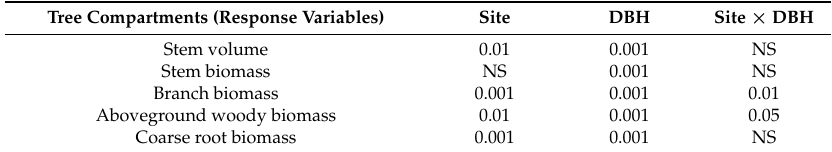
Table 2. ANCOVA results ( p -value) of testing Site as a main effect and diameter at breast height (DBH) as a continuous covariate, and the interaction effect between the main effect and the covariate on the response variables. Data were log-transformed prior to